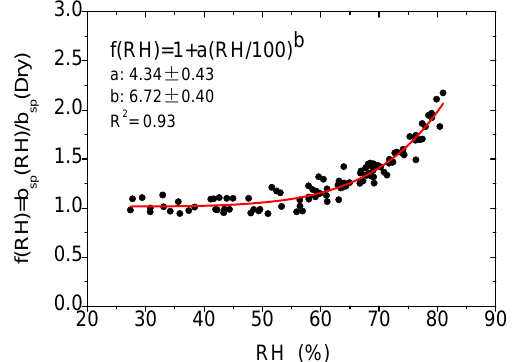
Fig. 11. Hygroscopic growth for aerosol scattering f (RH) as a function of RH with curve fitting. Scattered dots are the measured f (RH) and the line is the empirical fitting curve.